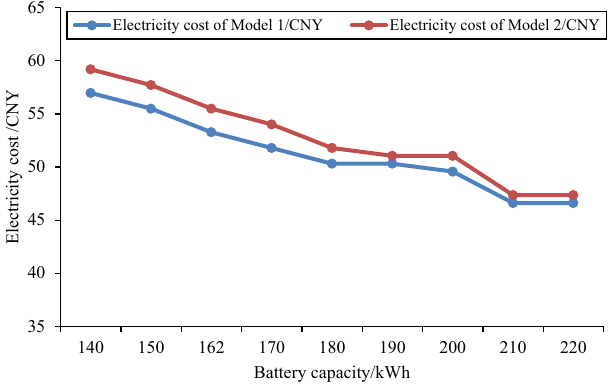
Table 11. Optimal charging plans under different price gaps